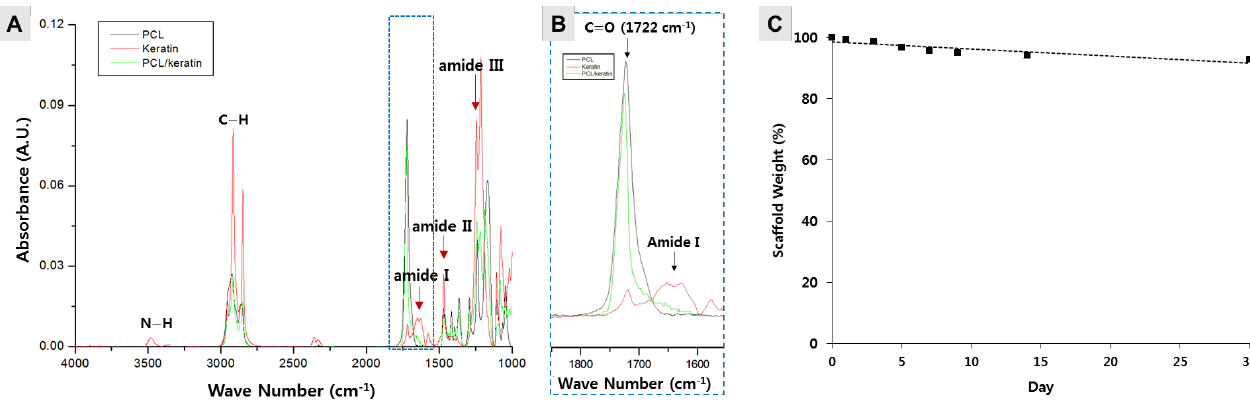
Figure 2. Analysis of PCL/keratin. ( A ) FT-IR spectra analysis, ( B ) zoom graph section of FT-IR, and ( C ) weight measurement of PCL/keratin 40% ( w / v ) membranes.